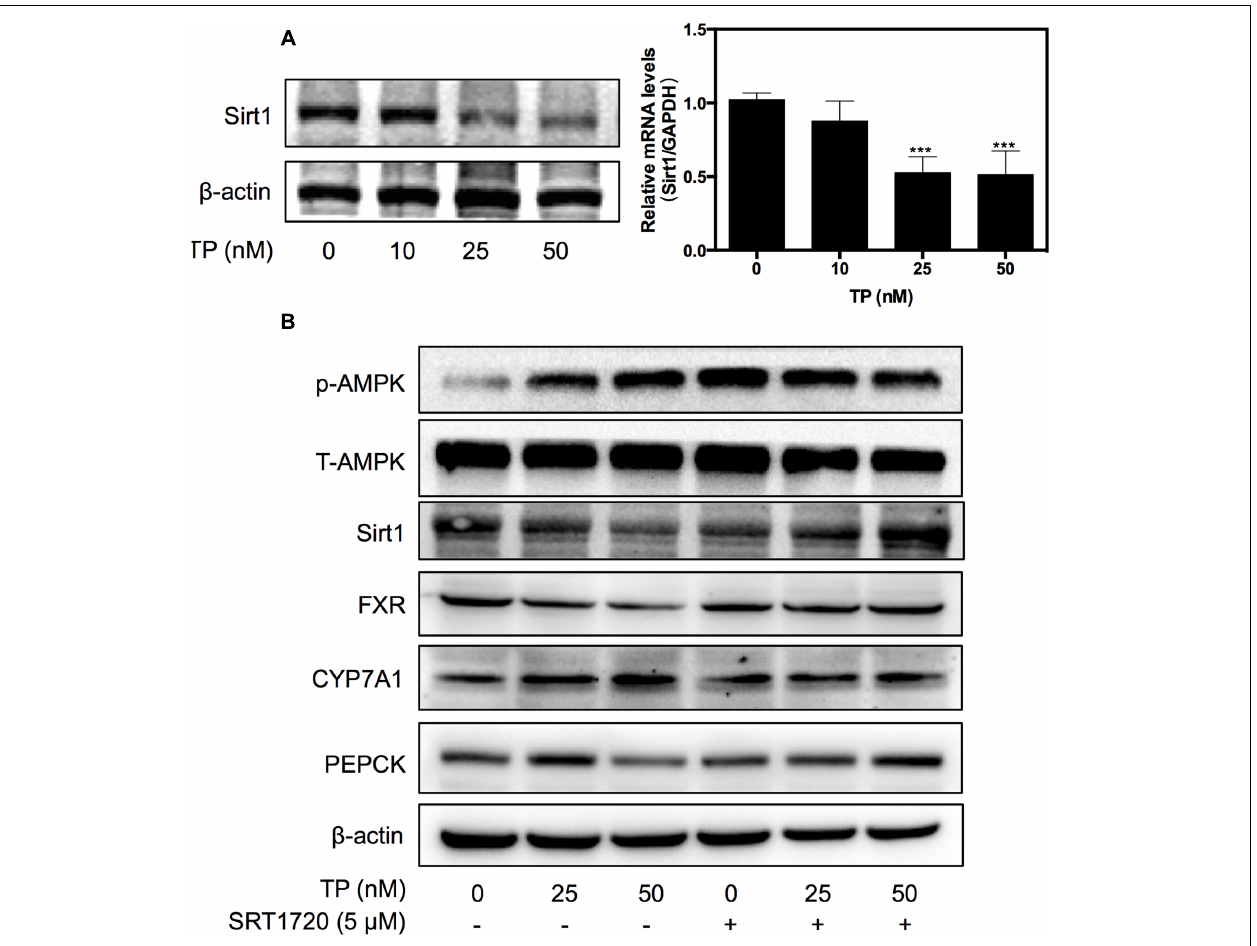
FIGURE 2 | Effect of Sirtuin (Sirt1) in TP-induced FXR suppression. (A) Primary rat hepatocytes were treated with TP for 8 h. Sirt1 expression was determined using real-time RT-PCR and western blot analysis. (B) Primary rat hepatocytes were pretreated with a Sirt1 agonist, SRT1720 (5 µ M), for one hour and then treated with TP for 8 h. The specific protein levels were determined using western blot analysis and normalized to β -actin as a loading control. Statistical significance relative to vehicle control, ∗ p < 0.05, ∗∗ p < 0.01, ∗∗∗ p < 0.001; and statistical significance relative to the corresponding treatment group without SRT1720, # p < 0.05, ## p < 0.01, ### p <